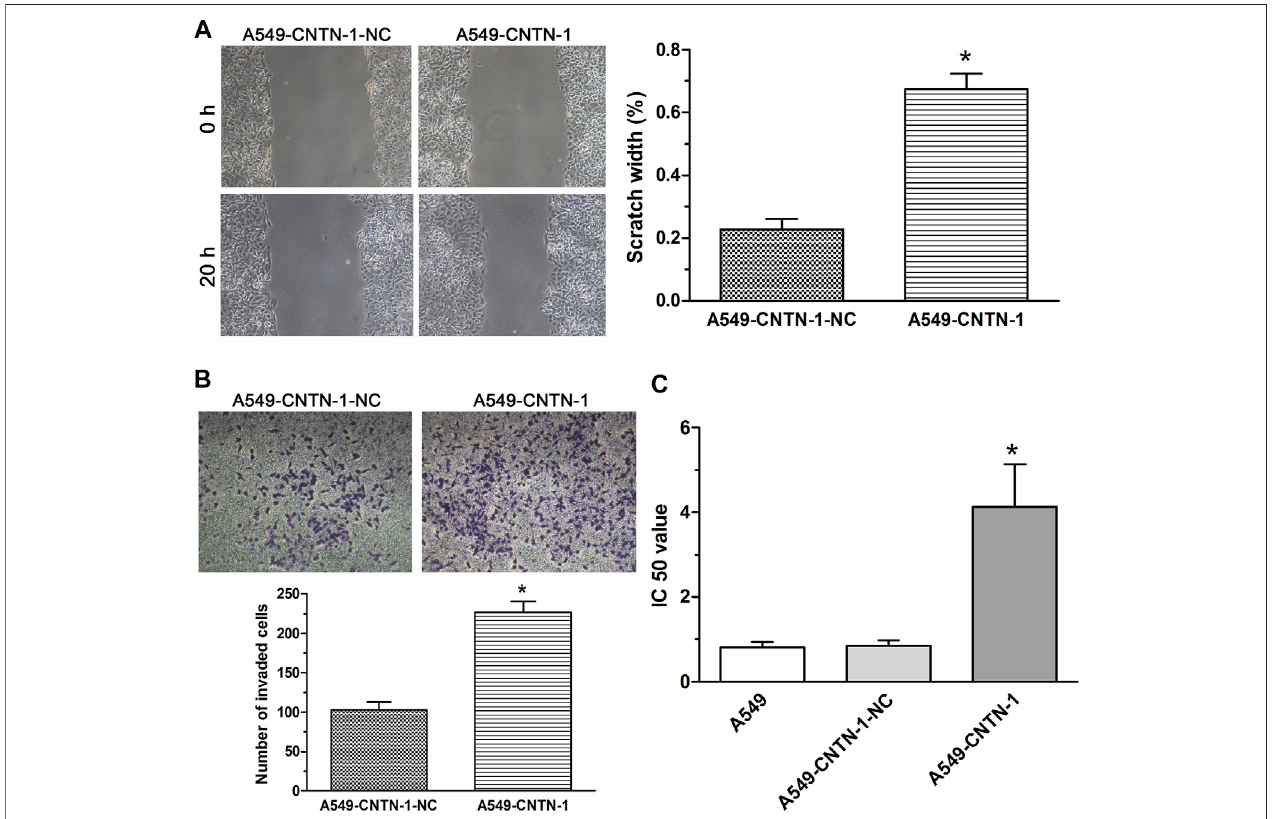
FIGURE 5 | EMT progression promoted by CNTN -1 overexpression. (A,B) Migration and invasion of A549- CNTN -1 cells were measured by wound healing assay andtranswellinvasionassay,respectively.BothmigrationandinvasionofA549- CNTN -1cellsweredramaticallyenhancedcomparedwiththatofcontrols(* p < 0.01). (C) Drug sensitivity of A549- CNTN -1 cells evaluated by CCK-8 method. A549- CNTN -1 cells were more tolerant to cisplatin than A549 cells (* p < 0.01). All pictures were photographed at a magni fi cation of ×100, scale bar = 100 um. Each experiment was conducted in triplicate and the data were expressed as mean ±